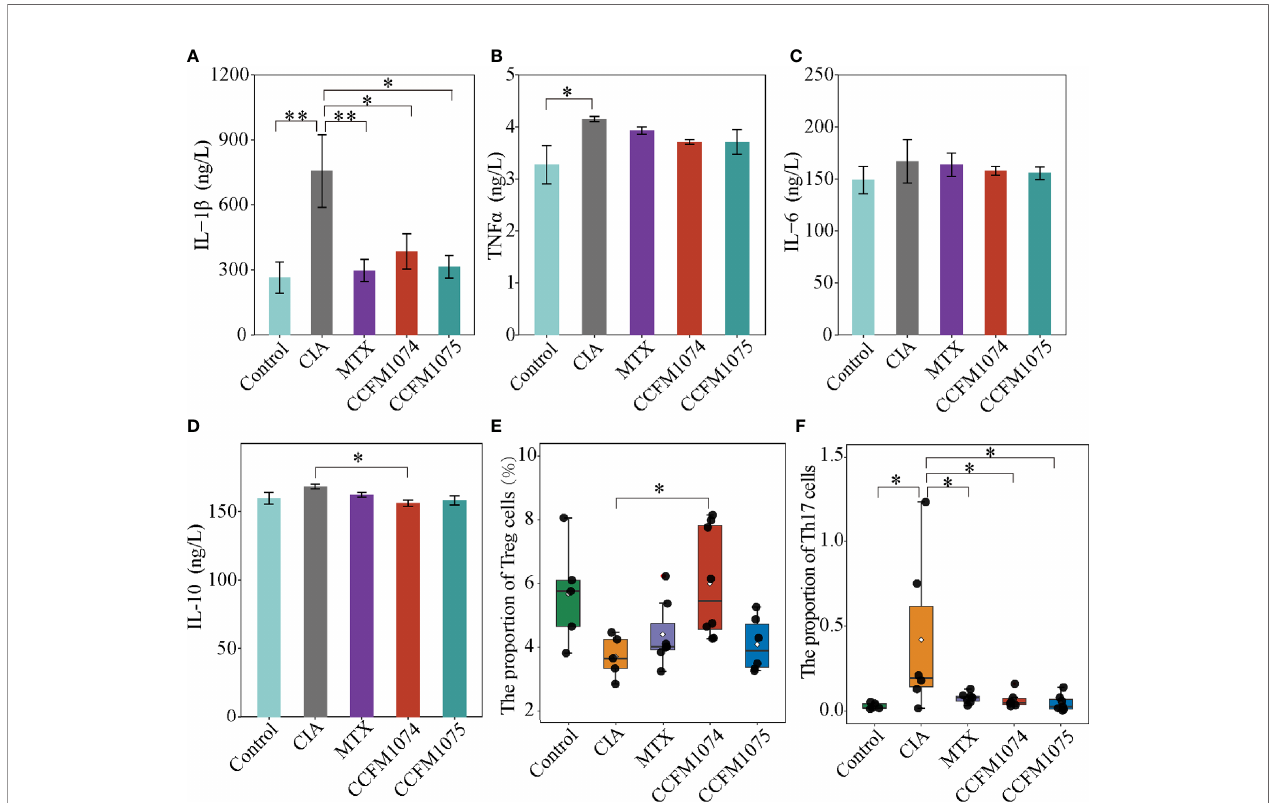
FIGURE 2 | Effects of L. casei on in fl ammatory responses in rats. The levels of IL-1 b (A) , TNF a (B) , IL-6 (C) and IL-10 (D) in plasma were determined by ELISA. The percentage of Treg cells (E) and Th17 cells (F) in MLN were determined by fl ow cytometry. control (vehicle-treated with saline 1.5 mL/day) group, CIA (vehicle-treated with saline 1.5 mL/day) group, methotrexate (MTX)-treated (6 mg/kg/week) group, CCFM1074 (treated with CCFM1074, 8.5 × 10 9 CFU/day) group and CCFM1075 (treated with CCFM1075, 8.5 × 10 9 CFU/day) group, eight rats per group. * p <0.05, ** p <0.01 (one-way ANOVA test with Tukey ’ s multiple comparisons